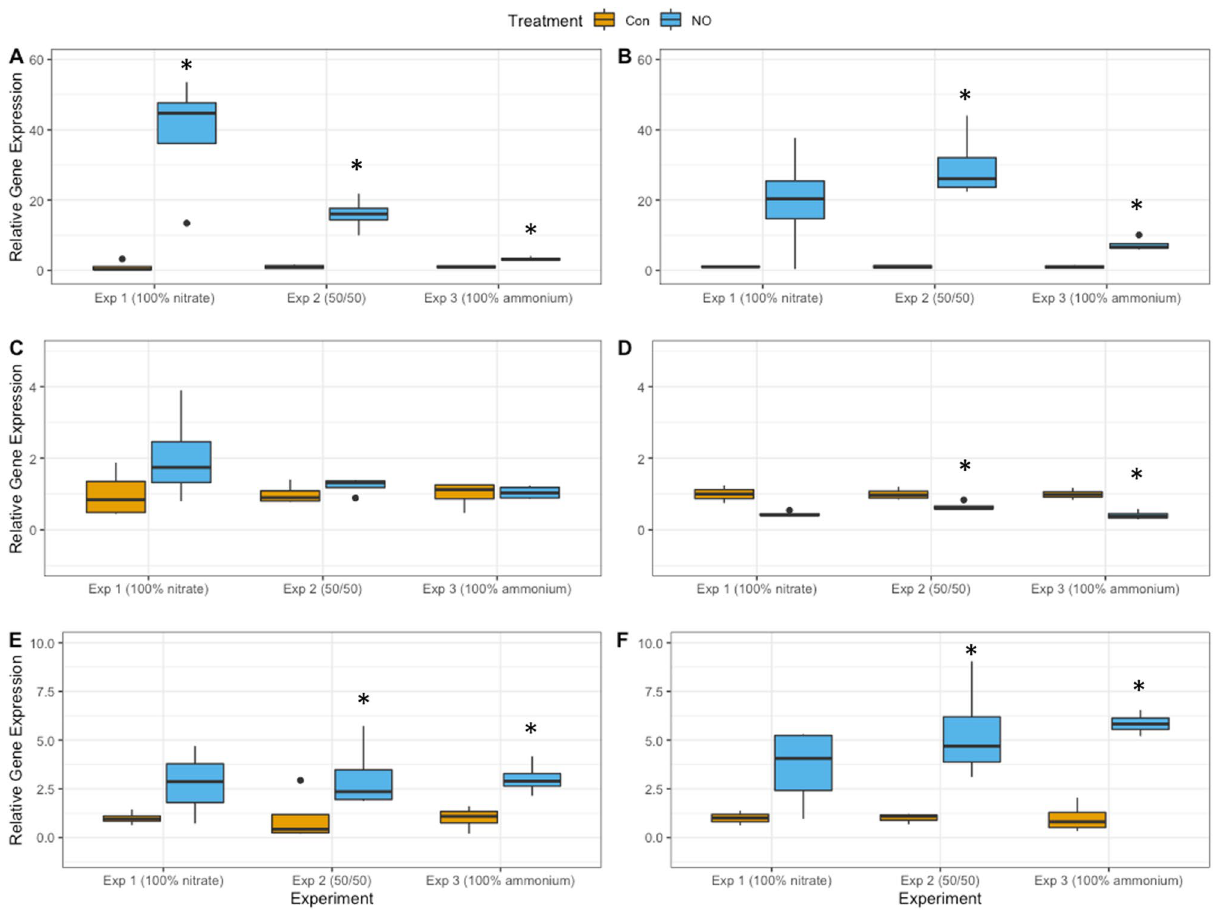
Figure 2. Gene expression analysis of Heterosigma akashiwo after spiking with NO. Relative gene expression of nitrate reductase ( NR ; A , B ), glutamine synthetase ( GS ; C , D ) and glutamine:2-oxoglutarate aminotransferase ( GOGAT ; E , F ) at 15 min ( A , C , E ) and at 60 min ( B , D , F ) after spiking with NO for control and treatment cultures of Heterosigma akashiwo when acclimated to growth on 100 µM nitrate (Exp 1), 50 µM nitrate and 50 µM ammonium (Exp 2), or 100 µM ammonium (Exp 3). Expression was normalized to GAP transcript abundance. Error bars are + /− 1 standard deviation from the mean. Significant difference in relative expression of genes in the nitric oxide treatment compared to controls (*) is